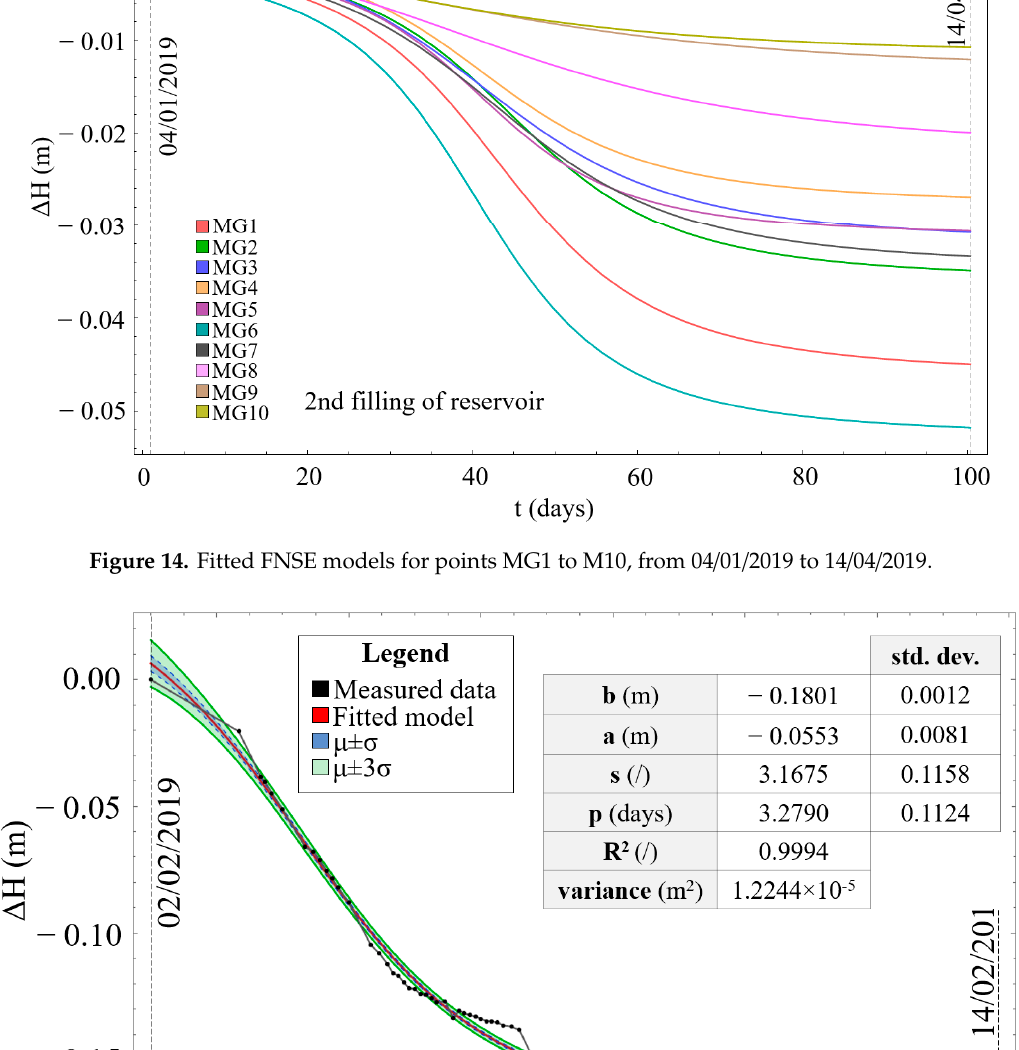
Figure 14. Fitted FNSE models for points MG1 to M10, from 04/01/2019 to 14/04/2019.